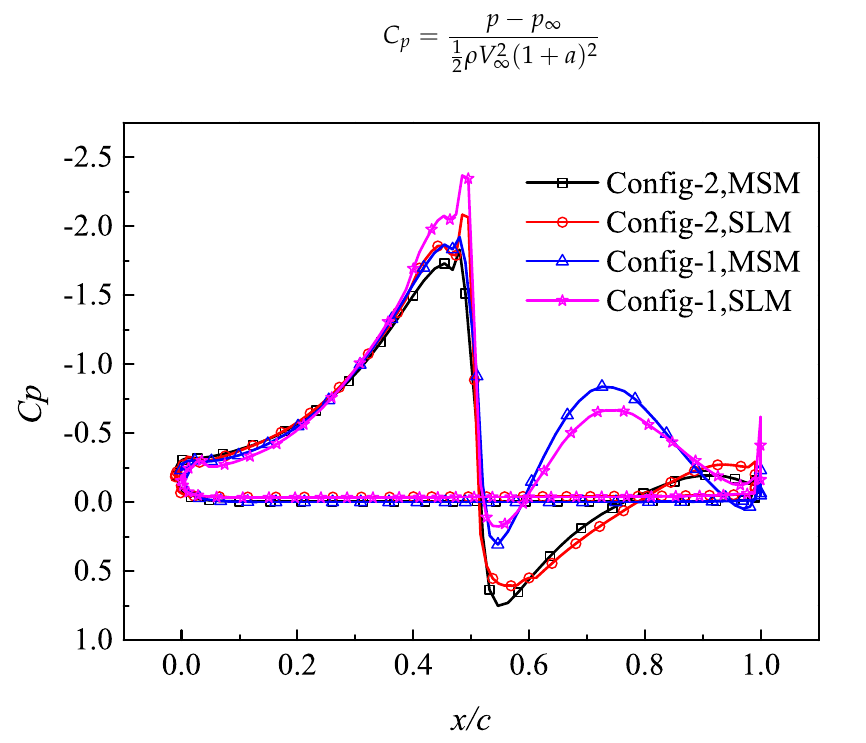
Figure 6. Pressure coefficient at wing symmetry plane from Momentum Source Method (MSM) and Sliding Mesh (SLM).